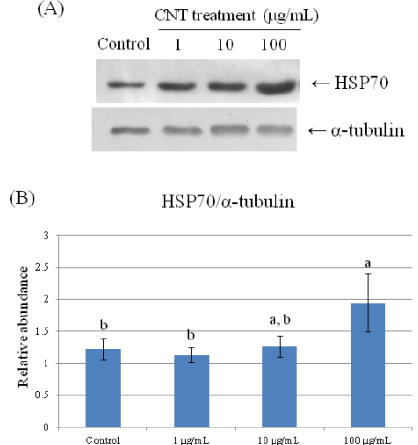
Figure 7. Validation of HMG1 in CNT-treated chicken macrophages by Western